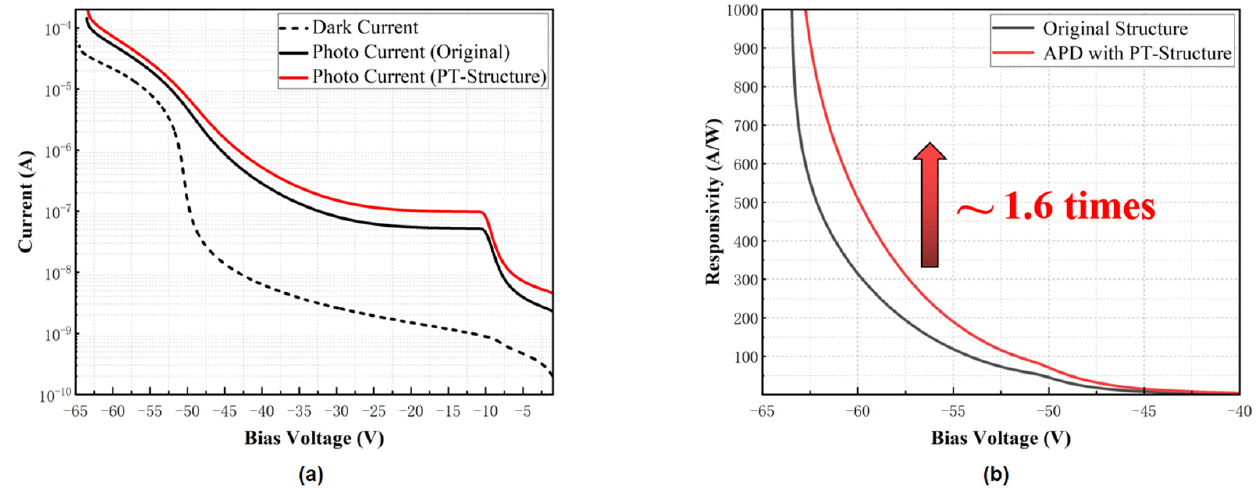
Figure 9. The simulated ( a ) I-V curve and ( b ) responsivity of the SAGCM-InGaAs/Si APD with and without PT structure (the mesa-size of APD is 8 μ m × 8 μ m, and the input optical power is 100 nW).